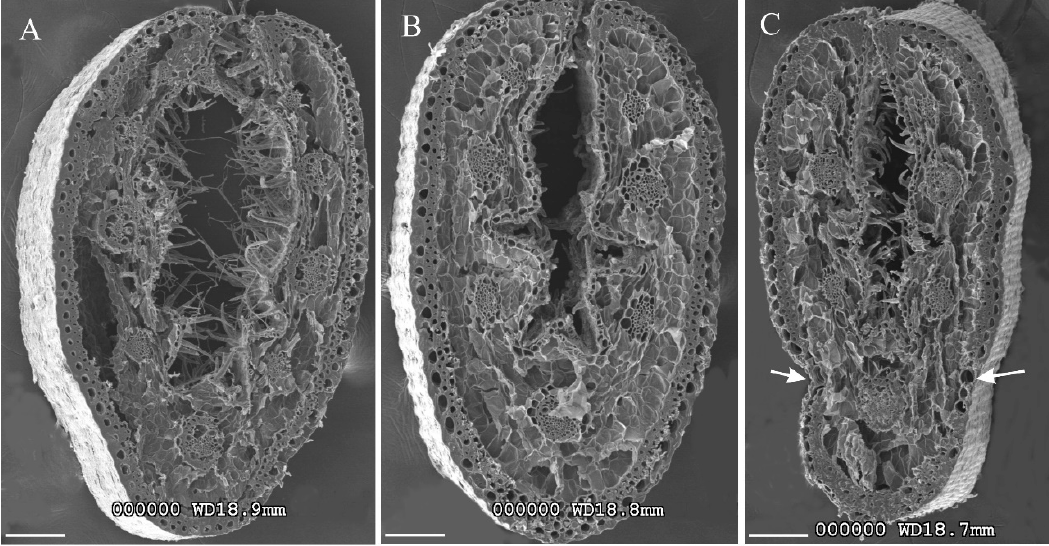
Figure 6. SEM pictures of the typical leaf cross sections. ( A ) F. vaginata ( B ) F. pseudovaginata ( C ) F. tomanii . White arrows show the interruptions of the continuous sclerenchyma ring at F. tomanii . The line represents 100 µm.